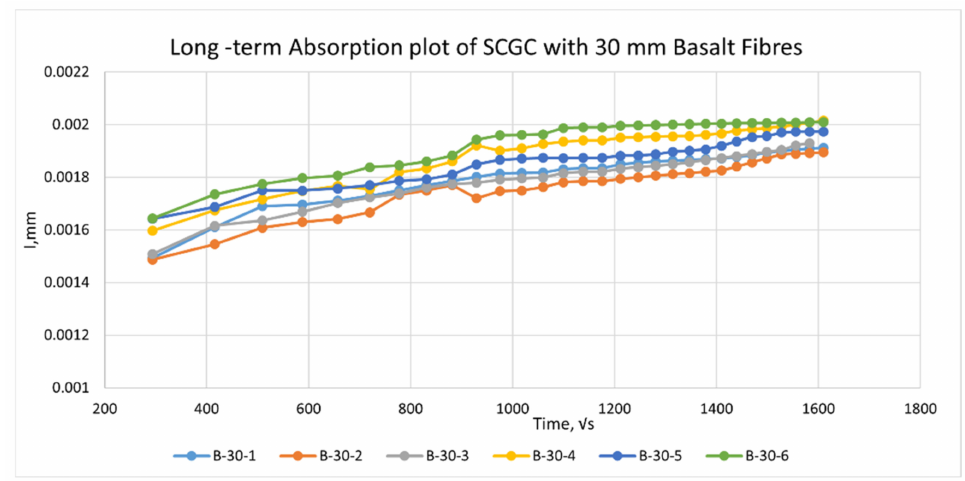
Figure 12. Long-term absorption plot of SCGC with 30 mm basalt fibres.